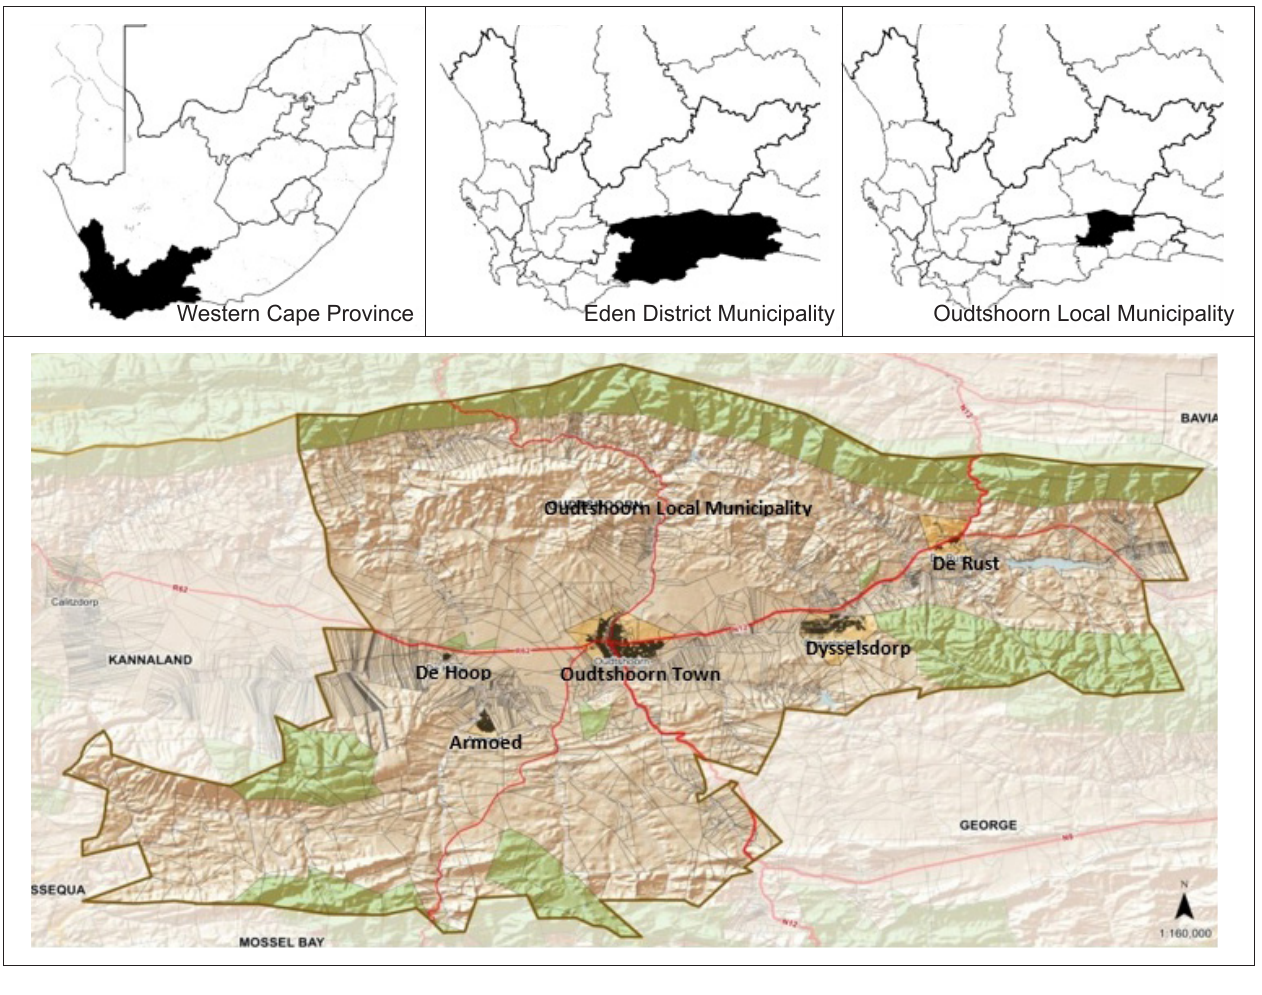
Figure 1: The OLM within South Africa